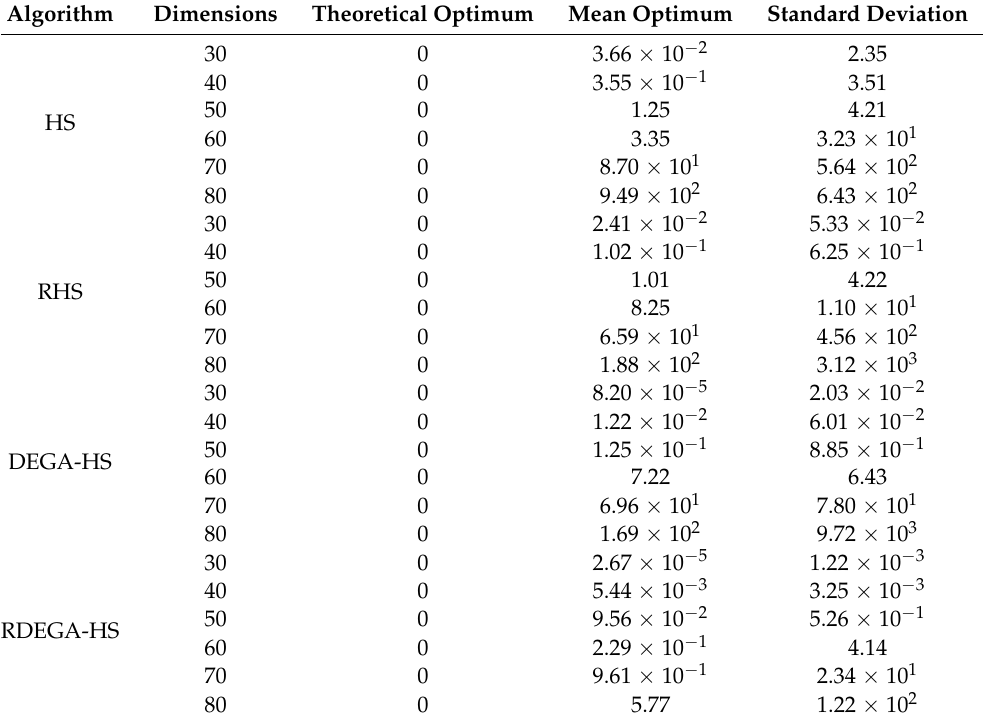
Figure 4. Change in average optimal fitness value of Ackley function with number of iterations. Table 4. Result of the Ackley function under different optimization